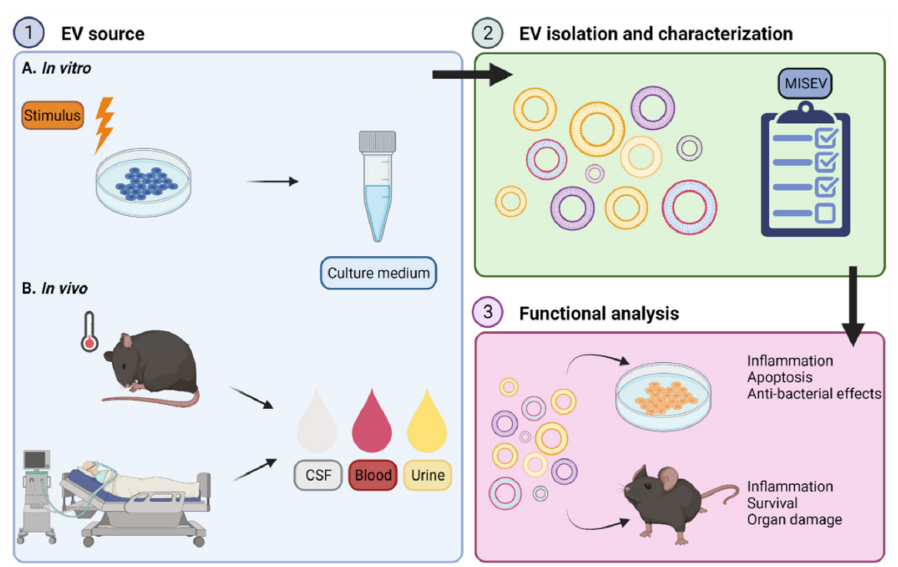
Figure 2. General set-up for functional analysis of extracellular vesicles (EVs). ( 1 ) EVs